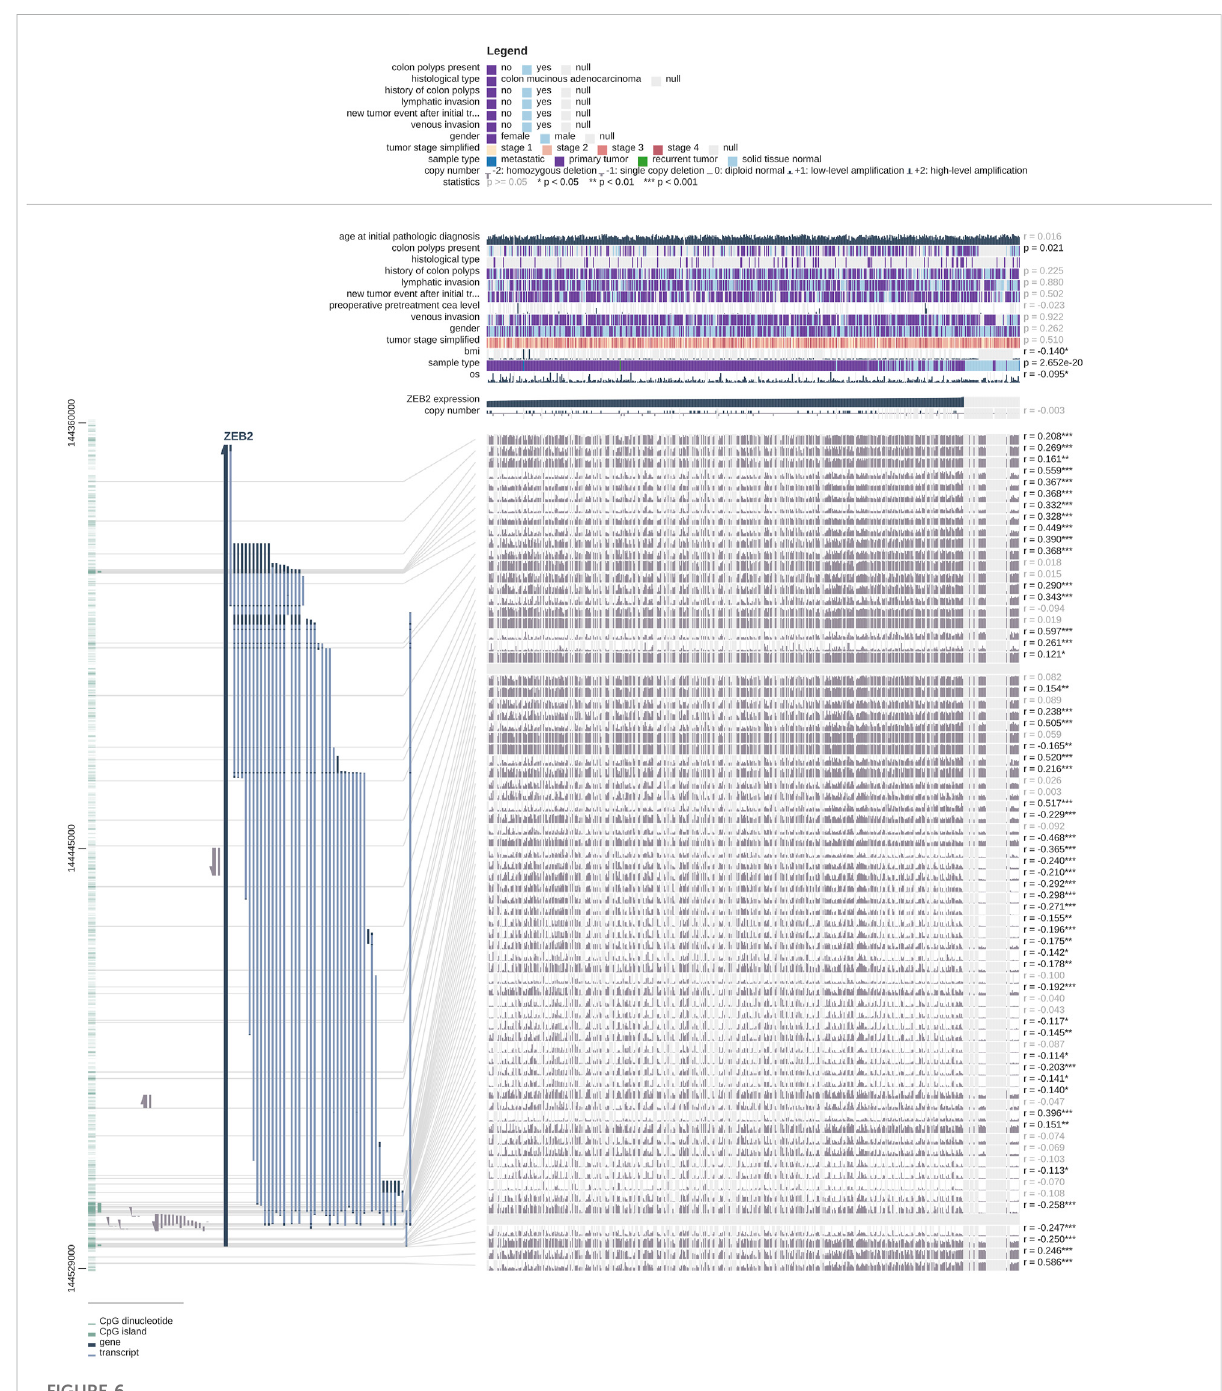
FIGURE 6 Correlation between clinical features and ZEB2 methylation